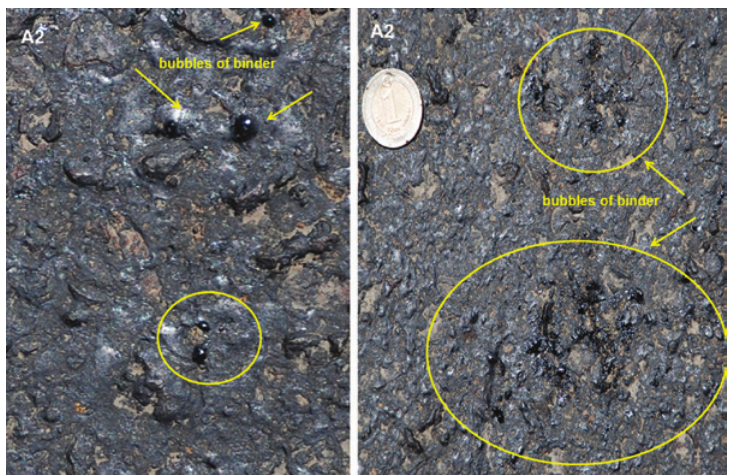
Figure 7: Binder bubbles due to the tendency of vaporization of moisture at base layer during summer